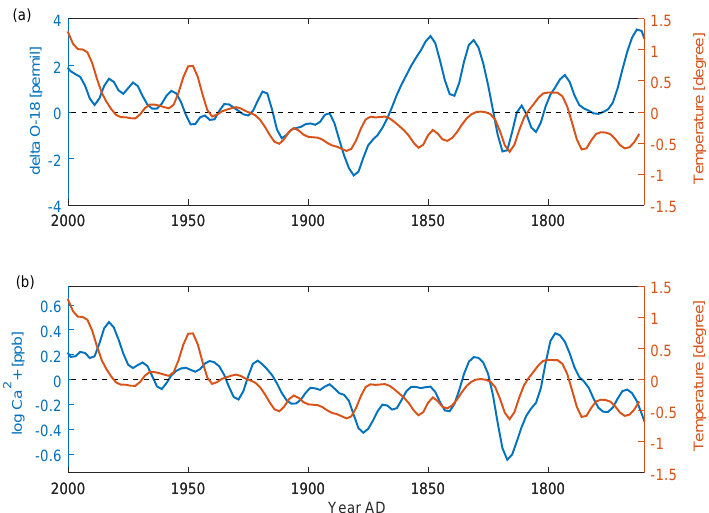
Figure 6. Comparison of KCC δ 18 O and Ca 2 + against the CG modified instrumental temperature (orange), shown in (a) and (b) , respectively, and covering the full instrumental period back to AD1760. Anomalies are shown relative to the respective AD2000–1860 mean, and as decadal trends obtained from Gaussian